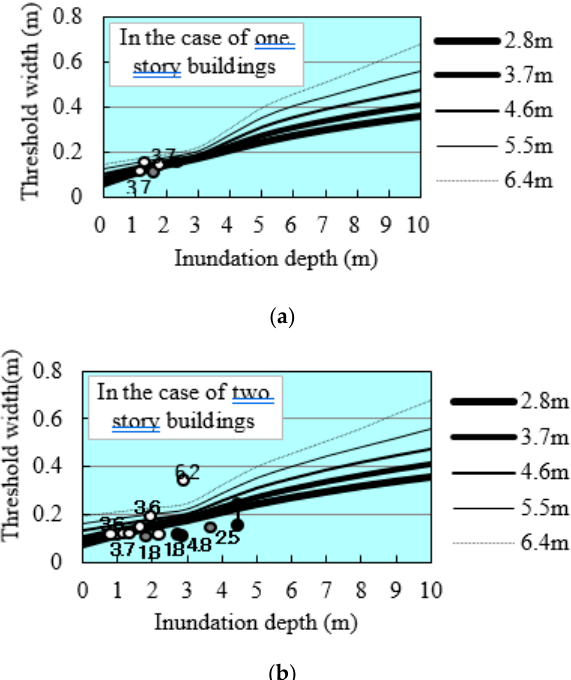
Figure 30. ( a ) Relationship between inundation depth and critical width of wooden pillars (the numbers in the figure are the pillar intervals). ( b ) Relationship between inundation depth and critical width of wooden pillars (the numbers in the figure are the pillar intervals).